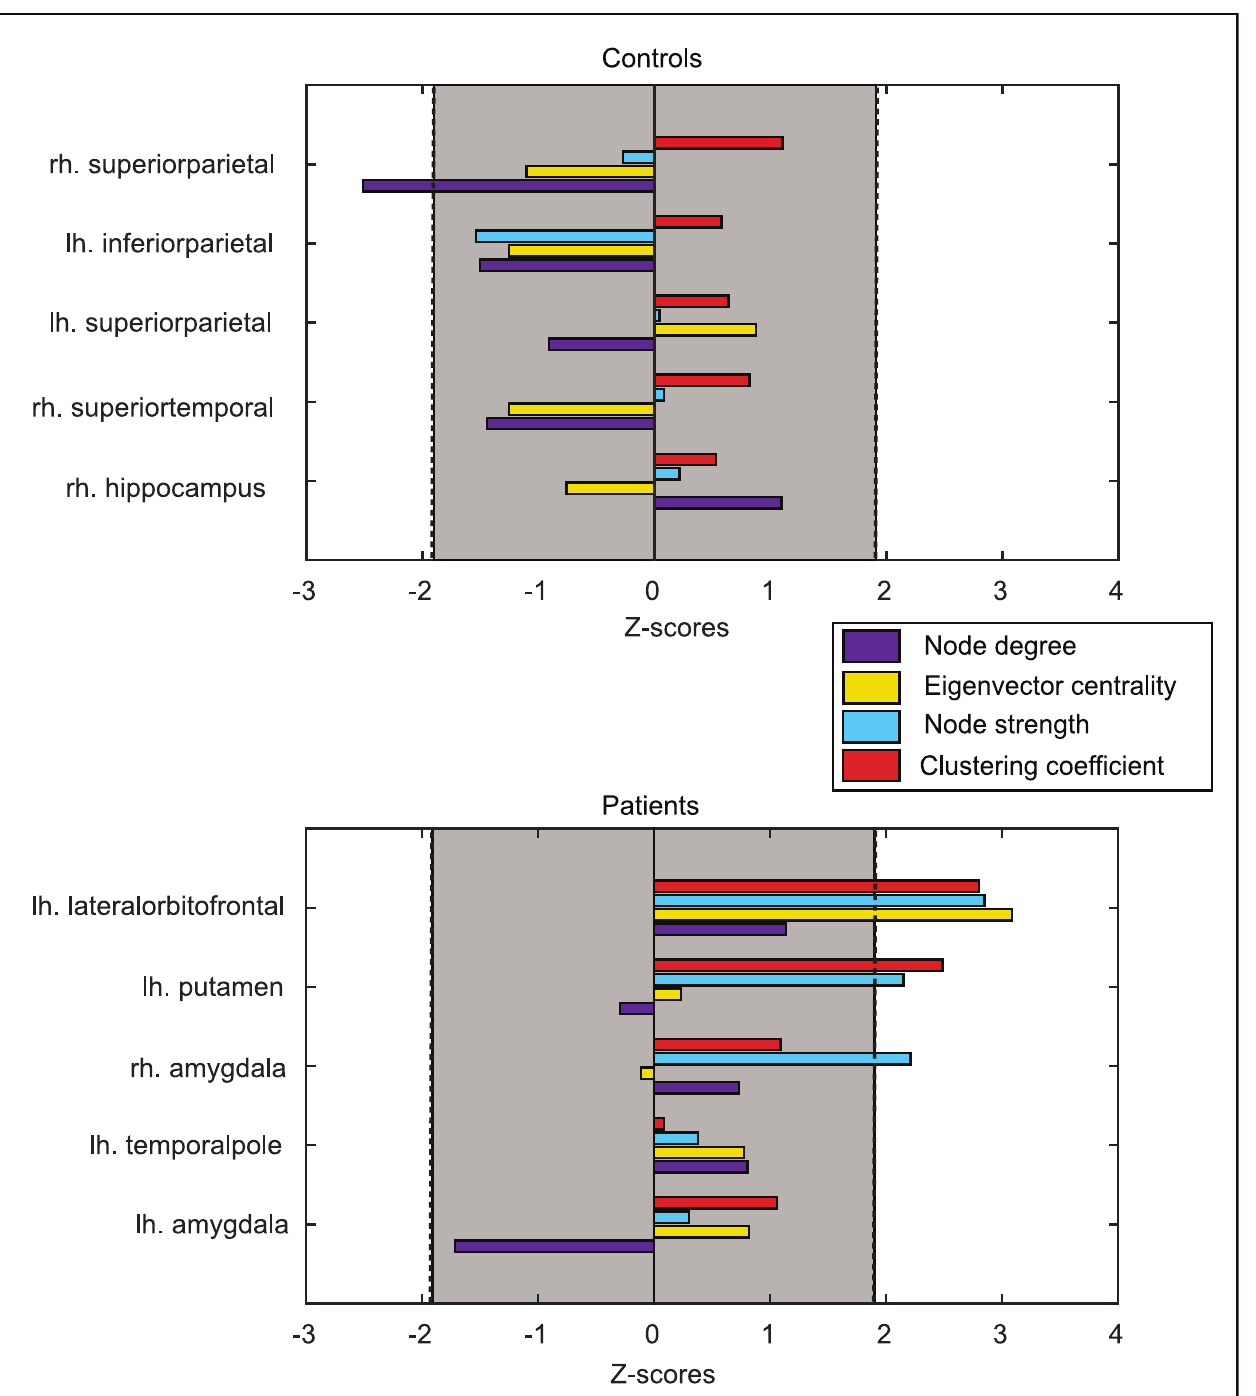
Fig 4. Commonly escaping nodes which differ between patients and controls compared. As these nodes have different escape time patterns in patients and controls we checked for network differences between the two groups. Z scores were found using a Mann-Whitney U test comparing network measures for the unshared nodes between patients and controls. A negative value means that the node score was lower in patients than in controls, and a positive z score means the node score was higher in patients than in controls. There are no clear differences which implies more complex origins for the different escape time